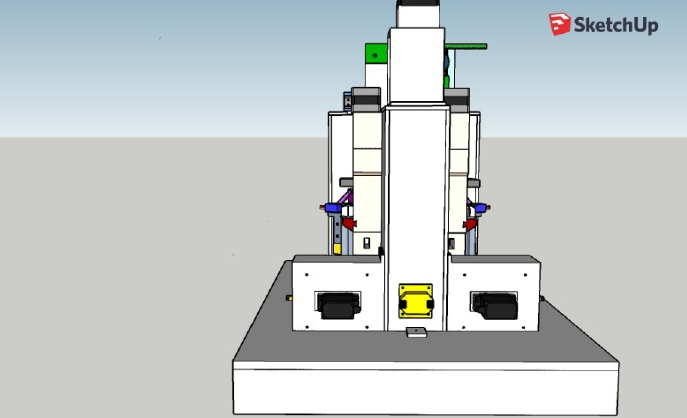
Figure 13. Full automated behavior box: front view.